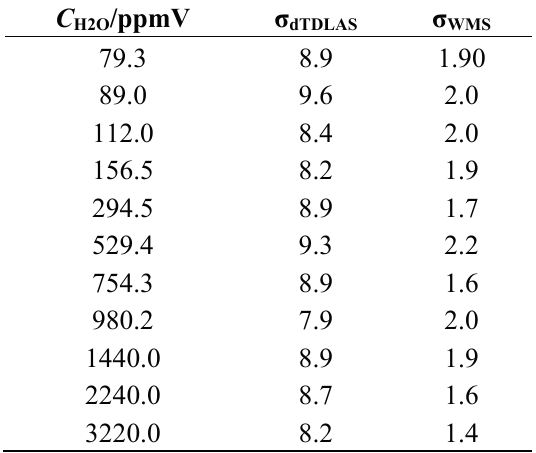
Table 1. Standard deviations during stable H 2 O concentration step